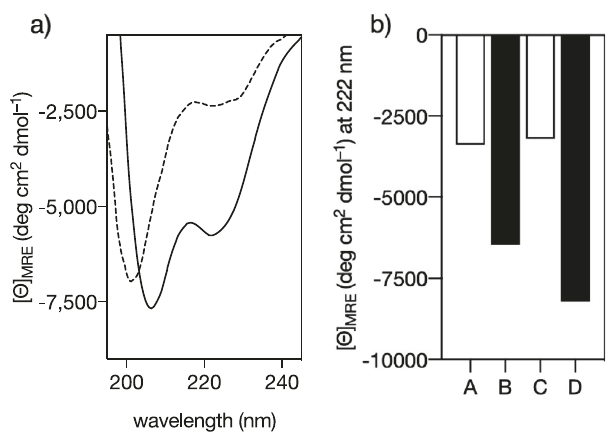
Fig. 2 Circular Dichroism studies show that the α -helical content of the peptide α H-His 2 can be switched. a Circular dichroism of a 20 µ M solution of α H-His 2 (dashed line) and the spectrum 30 min after addition of 1 eq. of µ M solution of α H-His cis -PdCl 2 (en); b CD signal at 222 nm for: A 20 2 ; B same solution after addition of Pd(II) and formation of the α H-His 2 [Pd] metallopeptide; C solution in B after addition of 5 eq. of DEDTC; D solution in C after addition of 20 eq. of cis -PdCl 2 (en). The experiments were carried out in 10 mM phosphate buffer pH 7.5, 100 mM of NaCl and 10% TFE, 25 °C. Mean residue molar ellipticity ([ Θ ]MRE) was calculated